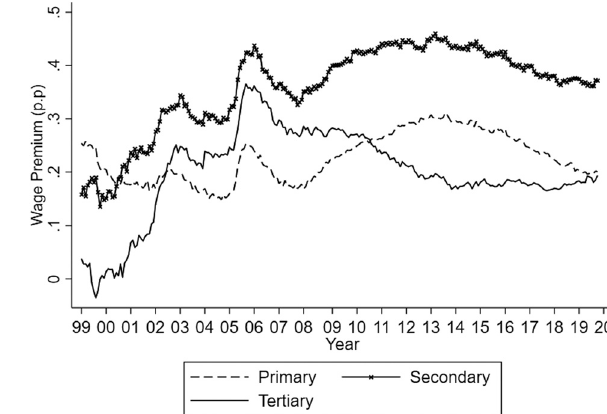
Figure A16: Wage premium by education attainment. Note: The wage premium is computed as ( , where w ¯ j t , is the monthly average wage for natives = j N and immigrants = j M at month t . Source: MCVL.